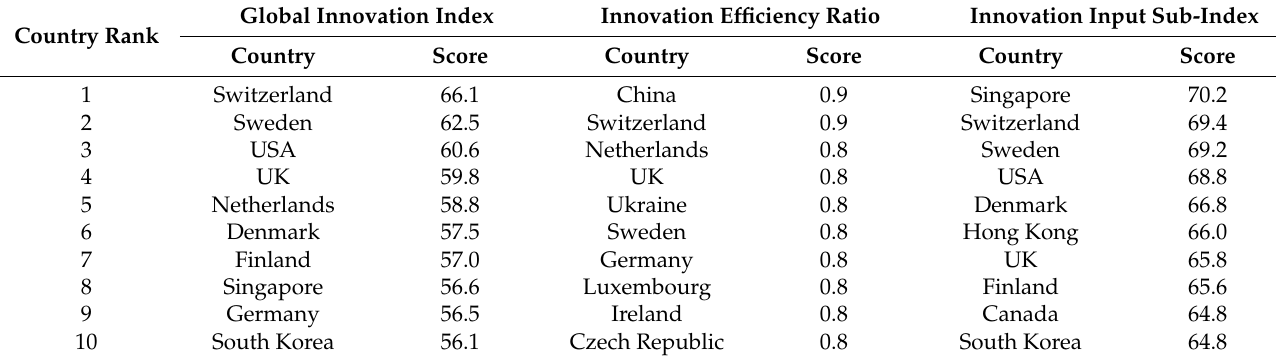
Table 5. Country ranking on innovation indicators.